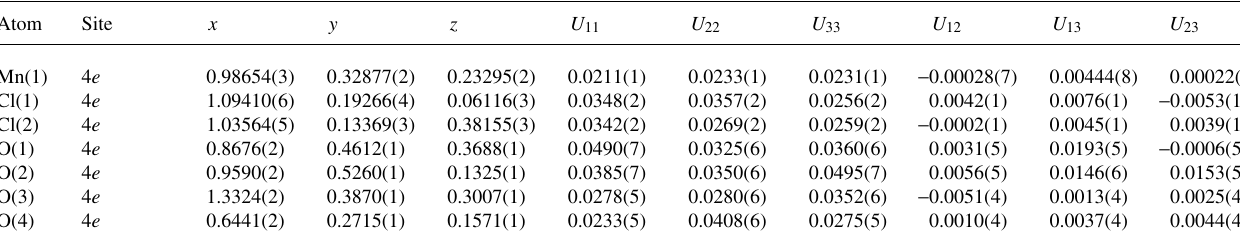
Table 3. Atomic coordinates and displacement parameters (in Å 2 )